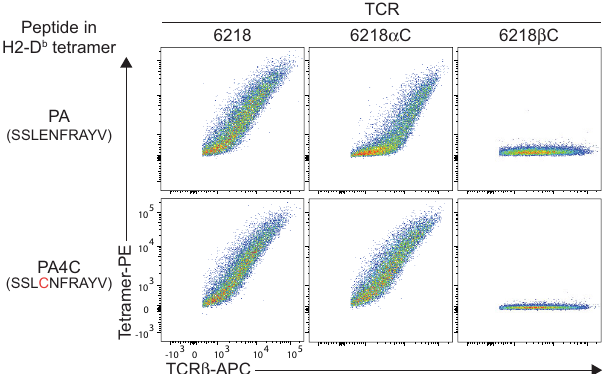
Fig. 4 | Context-dependent effects of Cys on TCR-pMHC binding. TCR trans- fectants expressing mouse CD3, GFP and the 6218, 6218 α C or 6218 β C TCR were incubated with anti-TCR β and tetramers of H2-D b presenting the indicated peptide (left).FACSplotsshowtetramerstainingversusTCR β expressiononliveGFP + TCR β + cells. Data arerepresentative of 6 experiments for cells expressing the 6218 TCR or the 6218 α C TCR and 1 experiment for cells expressing the 6218 β C TCR.